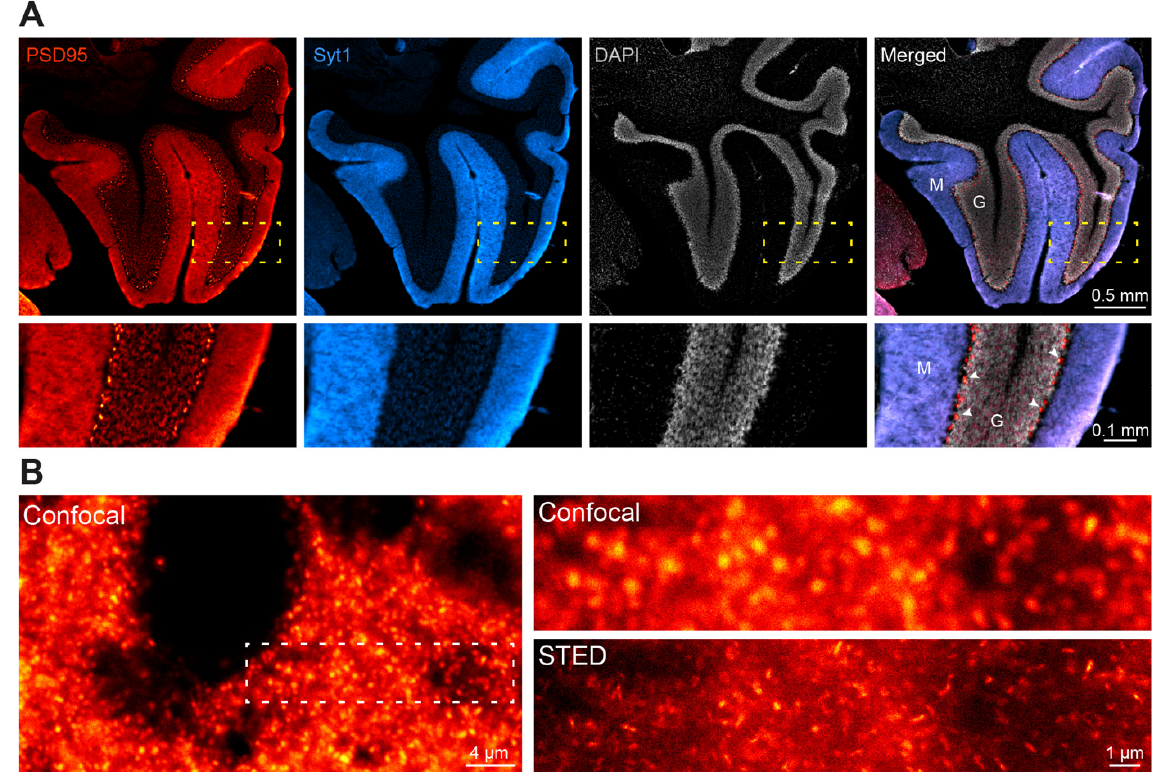
Figure 6. Super-resolution microscopy on formalin-fixed mouse cerebellar cortex. Brains were fixed in 4% formaldehyde for 24 h and cut into 50 µm thick sections using a vibratome. ( A ) Epifluorescence imaging overview of a cerebellar cortex section (top) and a zoom-in (bottom) on the granular cell layer (G) and molecular layer (M). AbberiorStar635p-conjugated NbPSD95 (red) was used for revealing post-synapses, and an antibody directed against Synaptotagmin 1 was used as a marker of pre-synapses (cyan). DAPI staining (gray) is only visible within the granular cell layer, while a majority of the staining by NbPSD95 and the anti-Syt1 antibody are found on the molecular layer. In addition, NbPSD95 gives a bright signal in the Purkinje cell layer at the axosomatic synapses directly contacting the cell body of Purkinje cells (arrowheads). ( B ) high-magnification imaging using laser scanning confocal and STED imaging on the molecular layer (M). The signal obtained with NbPSD95 is sufficiently strong to even support enhanced resolution using STED microscopy on tissue.